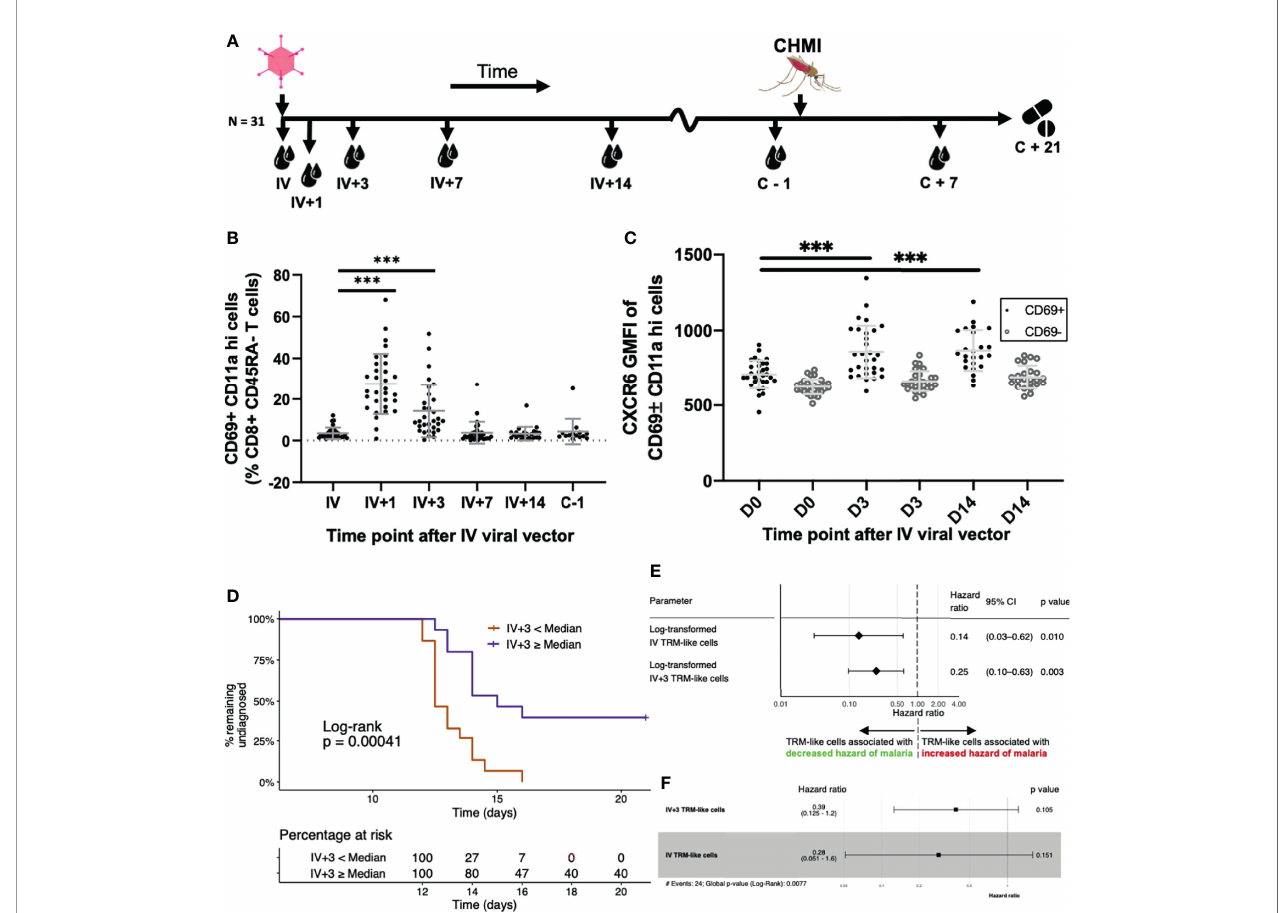
FIGURE 6 | Blood TRM-like cells can be used to estimate the hazard of malaria diagnosis after CHMI. (A) Sampling work fl ow. Thirty-one volunteers across all vaccination groups were sampled at several time points following IV viral vector (IV+ timepoints) and around controlled human malaria infection. One volunteer from this cohort was not challenged. Five more control (non-vaccinated) volunteers were challenged and followed up at pre- and post-challenge time points, only. All volunteers were treated with standard anti-malarial therapy at day 21 post-CHMI or, if earlier, when they met our diagnostic criteria for malaria (see methods). (B) TRM-like cells after IV administration of viral vector. Frequency of circulating CD69+CD11ahi cells (as a proportion of CD8+CD45RA- cells) by time point. Comparisons were assessed using ratio paired t tests. Lines represent signi fi cant differences between the bound groups; bars show mean and standard deviation. (C) The GMFI of TRM-like cell CXCR6 at three different time points following IV viral vector. Comparisons were assessed using ratio paired t tests. Lines represent signi fi cant differences between the bound groups; bars show mean and standard deviation. Matched GMFI values of CD69- cells are also presented for reference. *** represents a p value < 0.0001. (D) Kaplan Meier curve using TRM-like cells 3 days after IV viral vector to stratify volunteers. Volunteers were strati fi ed according to whether their TRM-like cell fraction (as a proportion of CD8+ CD45RA- cells) at day 3 after IV viral vector was above or below the median of all values. A log-rank test was performed to test for difference in survival (delay/lack of malaria diagnosis). The risk table shows the percentage of volunteers, in each stratum, at risk of malaria diagnosis at fi ve representative time points. Right censoring occurred at 21 days as all undiagnosed volunteers received antimalarial therapy at this time. (E) Univariate Cox regression models using TRM − like cells [CD69+ CD11a hi frequency (% CD45RA- CD8+ CD3+ T cells)] measured at two time points. Each regression model estimated the effect that the variable had on an individual ’ s hazard of being diagnosed with malaria after CHMI. Hazard ratios less than one suggested that an increase in the TRM − like cell frequency decreased the instantaneous risk of malaria diagnosis over the study period. Hazard ratios greater than one suggested that a decrease in TRM − like cell frequency increased the instantaneous risk of malaria diagnosis over the study period. Log transformation was applied to the TRM − like cell frequency, and regression was performed on these values. The p value was calculated using a Wald test, with a null hypothesis that the parameter did not alter the hazard of malaria diagnosis after CHMI. (F) Multivariate Cox regression model using TRM like cells [CD69+ CD11a hi frequency (% CD45RA- CD8+ CD3+ T cells)] measured at two time points: IV and IV+3. Hazard ratios and 95%CI are presented. Log transformation was applied to the TRM − like cell frequency, and regression was performed on these values. The individual variable p values were calculated using a Wald test. The global p value was calculated using a Score (log − rank) test. Events refers to the number of volunteers that were diagnosed with malaria. AIC, Akaike information criterion; C, challenge; CHMI, controlled human malaria infection; D, day; GMFI, geometric mean fl uorescence intensity; IV, intravenous viral vector administration; TRM, tissue-resident memory T